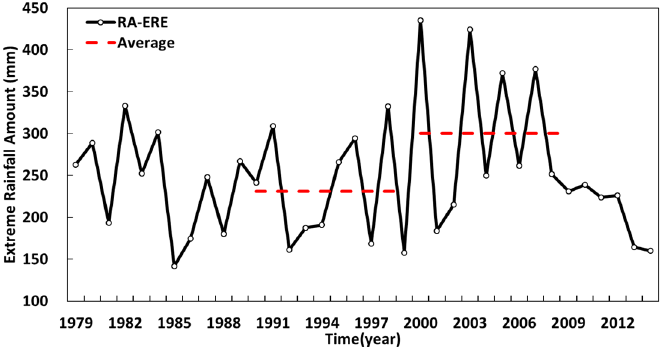
Figure 2. Time series of the summer (JJA) station-averaged rainfall amount (unit: mm) contributed by extreme rainfall events (RA-ERE, the black line with hollow circle) averaged from 189 stations over the HRB during the period 1979–2014. The two red dashed lines denote the 10-year averaged RA-ERE during the periods 1990–1999 and 2000–2009, respectively.